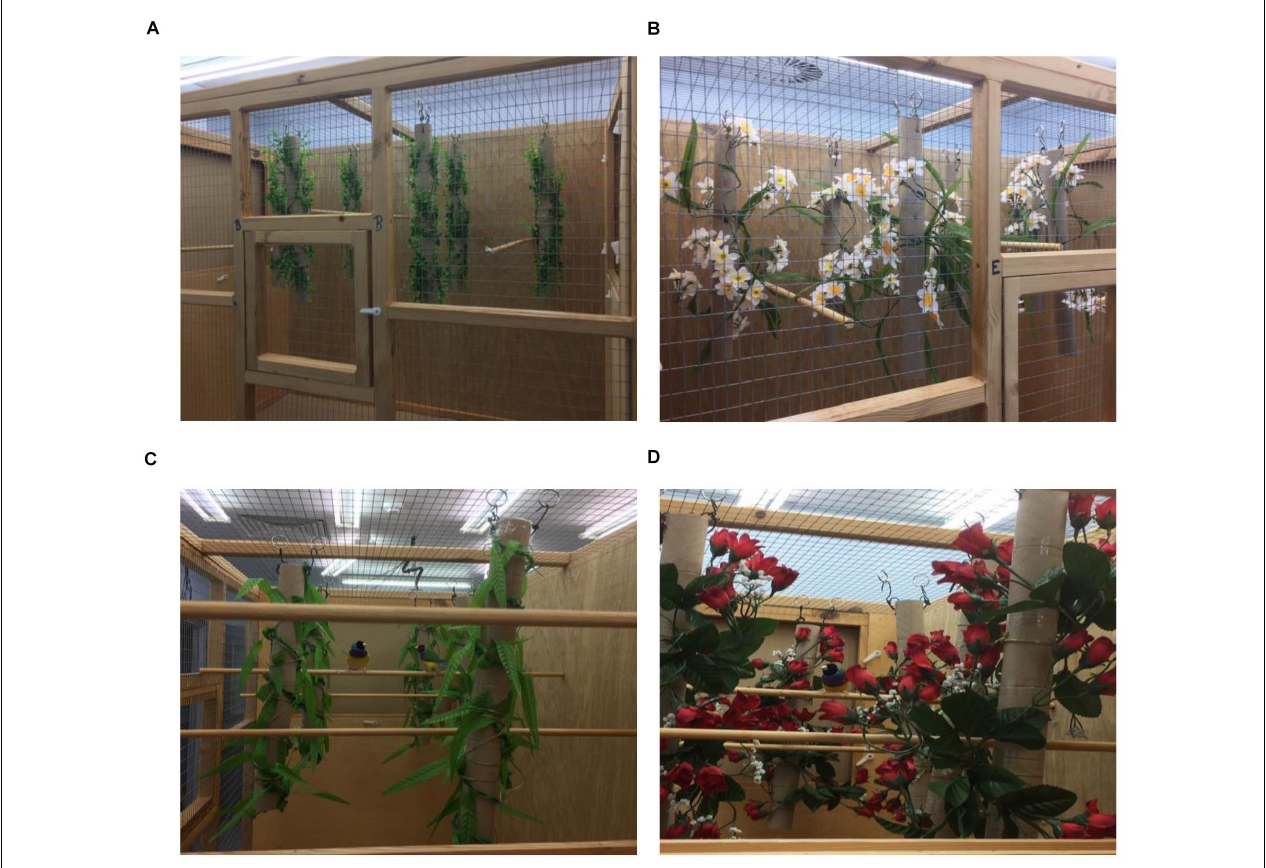
FIGURE 1 | Novel environments representing open and dense habitats. In the first experiment, pairs of Gouldian finches got access to an open habitat simulated by soft plastic eucalyptus leaves tightly woven around cardboard tubes (A) and a dense habitat simulated by silken daisies (B) . The pictures show the habitats from outside with access for the birds from either the right or left side. Experiments were repeated with different pair compositions and silken vines for the open habitat (C) and silken roses for the dense habitat (D) . The pictures show the view for the birds through the opened